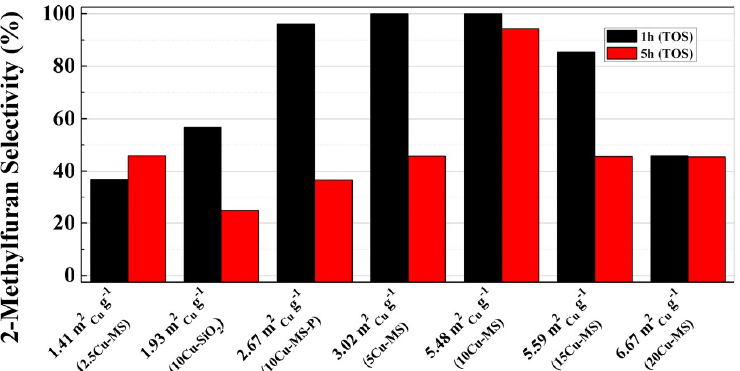
Figure 2. Influence of the surface area on the MF selectivity. Reprinted with permission from [62]. Copyright 2017 John Wiley and Sons.